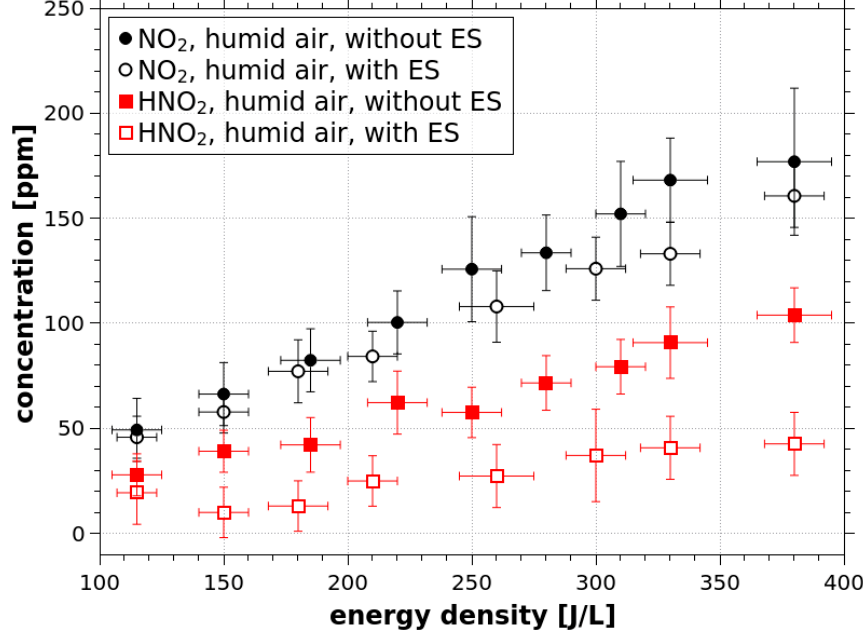
Figure 12. Comparison of NO 2 and HNO 2 concentration with and without post discharge ES treatment, measured by UV-Vis absorption technique, short cell,